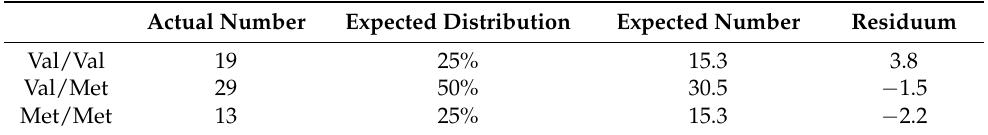
Table 3. Comparison of the COMT-Val/Val, Val/Met, Met/Met gene variants distribution in terms of expected versus observed distribution (Val = Valin, Met = Methionine, Residuum: Difference between the anticipated number versus the observed number of gene expression variants relative to the sample